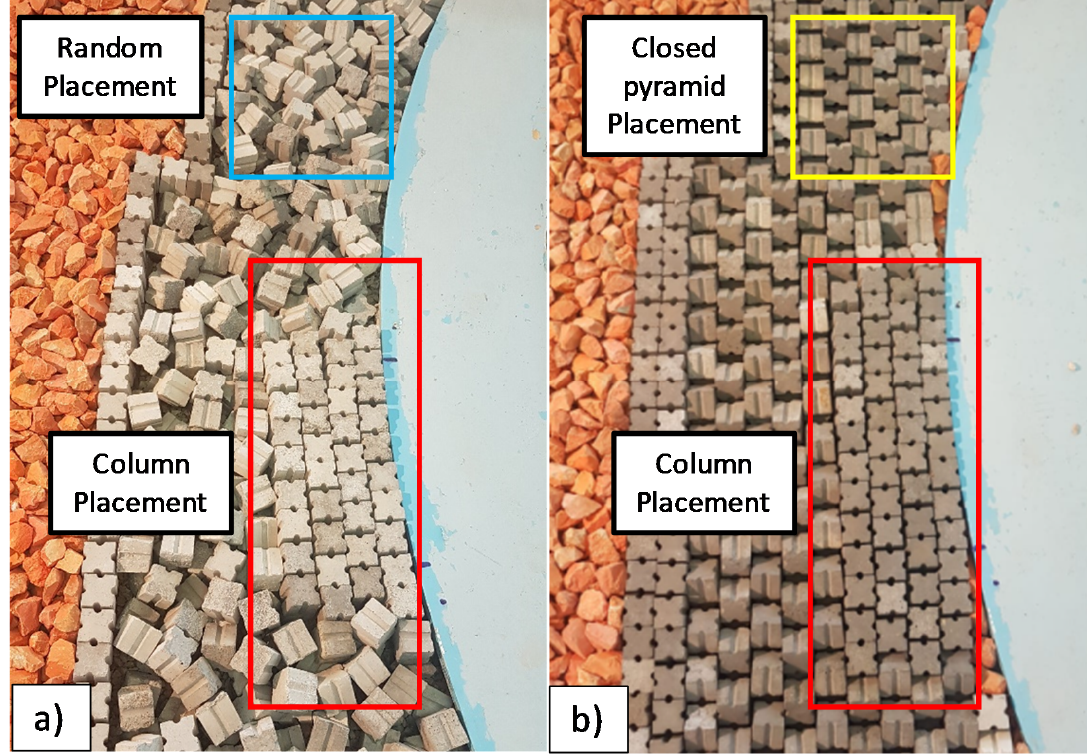
Figure 8. ( a ) Random placement and ( b ) closed pyramid placement of Antifer blocks.